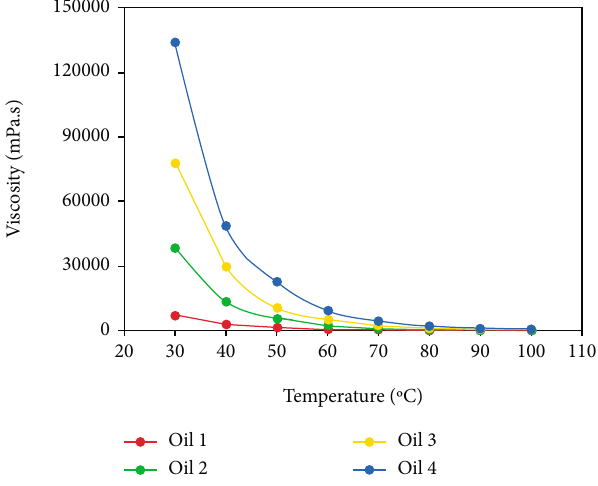
Figure 2: Viscosity – temperature